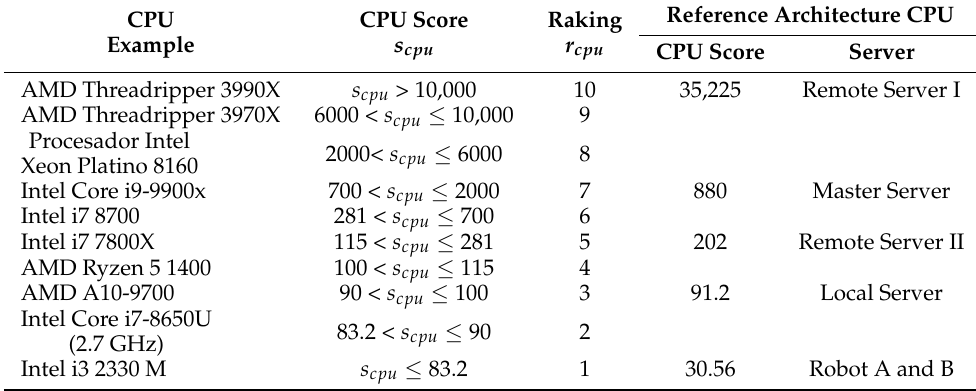
Table 1. Proposed CPU Score.